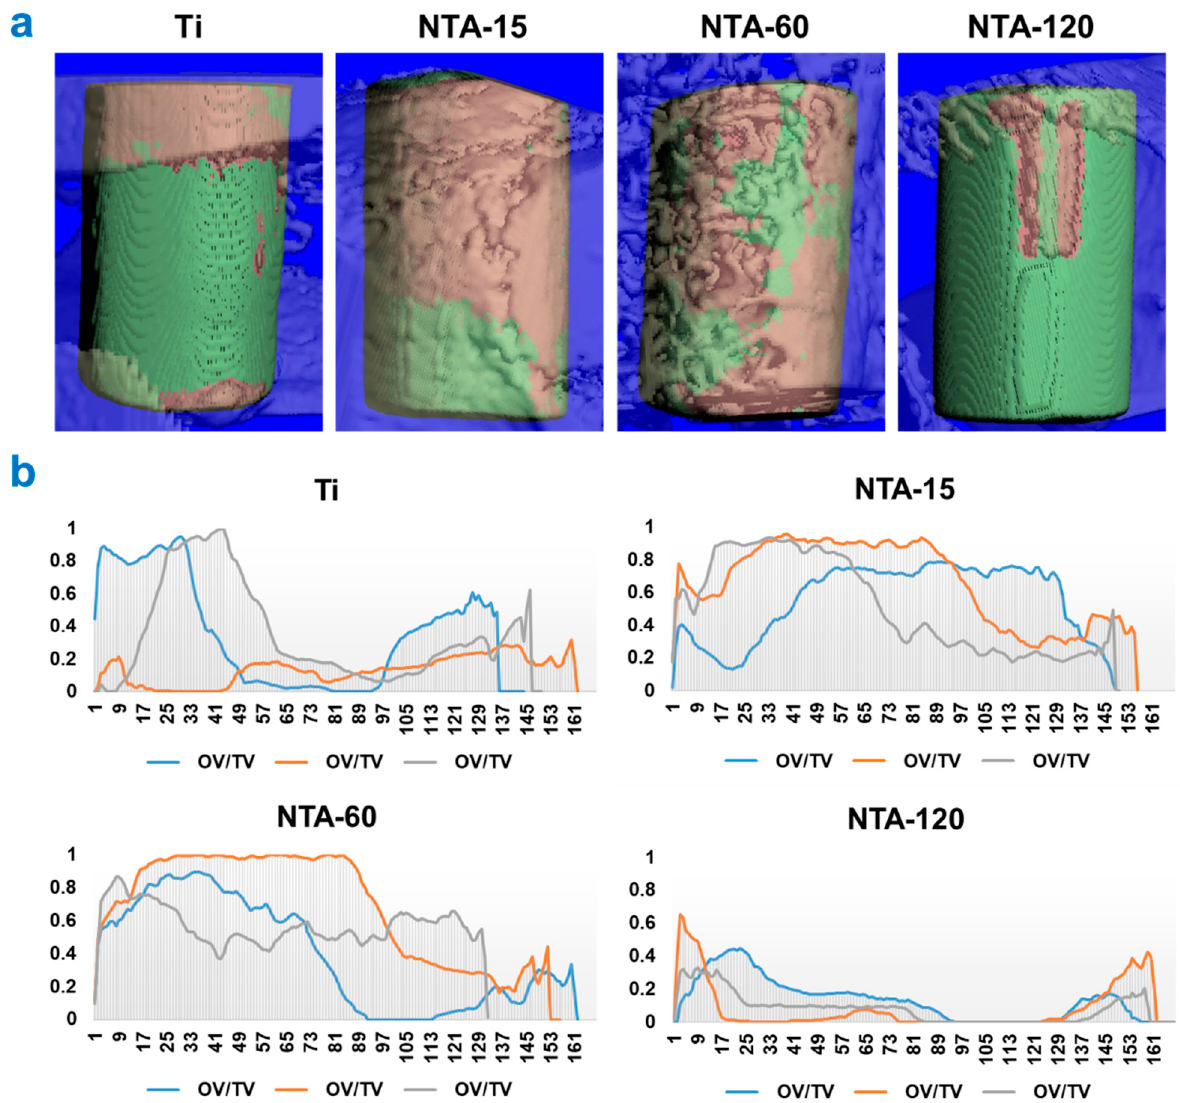
Figure 8. In vivo osseointegration of Ti and TNAs. ( a ) Three-dimensional rebuilt images of the implants and the peri-implant bone tissue; ( b ) original BIC profiles of each specimen obtained from the micro